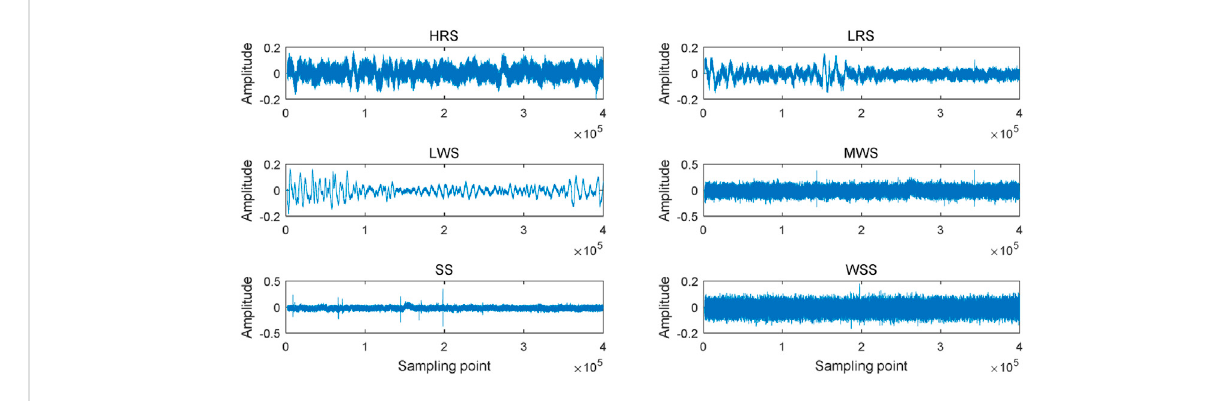
FIGURE 3 Time domain waveform of six ANs.